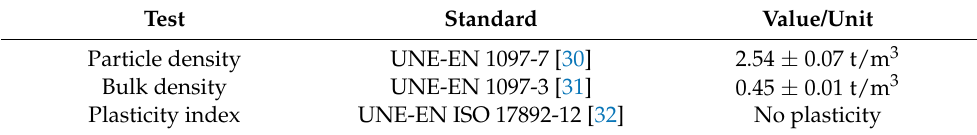
Table 7. Density and plasticity tests for the fine portion of biomass bottom ash.